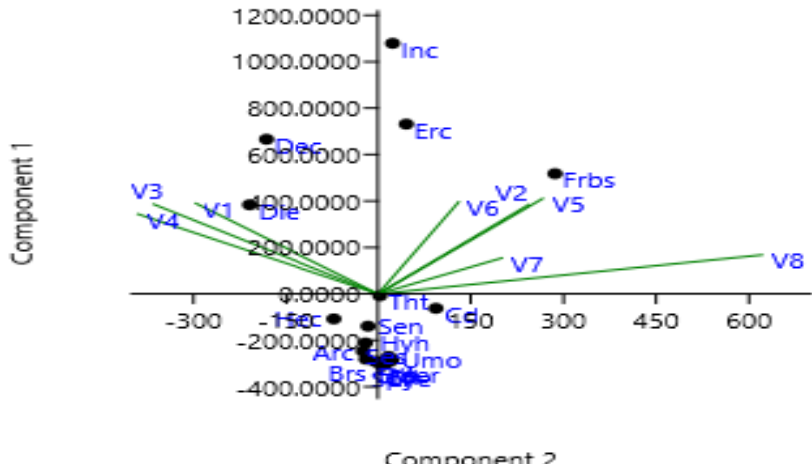
Figure 8. PCA plot showing the effect of resting period and rainfall reduction on overall biomass yield (kg.ha − 1 ) and other vegetation parameters in 2017/18. Key to symbols: Black dots ( ● ) indicate treatment and the season and vectors ( ) indicate the direction of the relationship between vegetation parameters and treatments. The longer the vector radiating from the centre, the stronger the effects of the resting period and the resting period and the closer the dot to the vector the stronger the relationship between species and soil property. V 1 = 0% RD, 70 RP, V 2 = 0% RD, 90 RP, V 3 = 15% RD, 70 RP, V 4 = 15% RD, 90 RP, V 5 = 30% RD, 70 RP, V 6 = 30% RD, 90 RP, V 7 = 60% RD, 70 RP, V 8 = 60% RD, 90 RP. Cd= Cynodon dactylon, Die = Digitaria eriantha, Erc = Eragrostis curvula, Tht = Themeda triandra , Erl = Eragrostis lehmaniana , Spf = Sporobolus fimbriatus, Hec = Heteropogon contortus , Sen = Setaria nigrirostris, Ses = Setaria sphacelata, Cye = Cymbopogon excavatus , Umos = Urochloa mosambicensis, Erb = Eragrostis barbinodes , Arc = Aristida congesta , Erpl = Eragrostis plana, Brs = Brachiaria serata , Hyh = Hypperhenia hirta , Mer = Melinis repens , Hei = Height, Ob = Overall biomass, Grss = Grass, Frbs = Forbs, Dec = Decreasers, Inc = Increasers, RUE = Rain use efficiency.